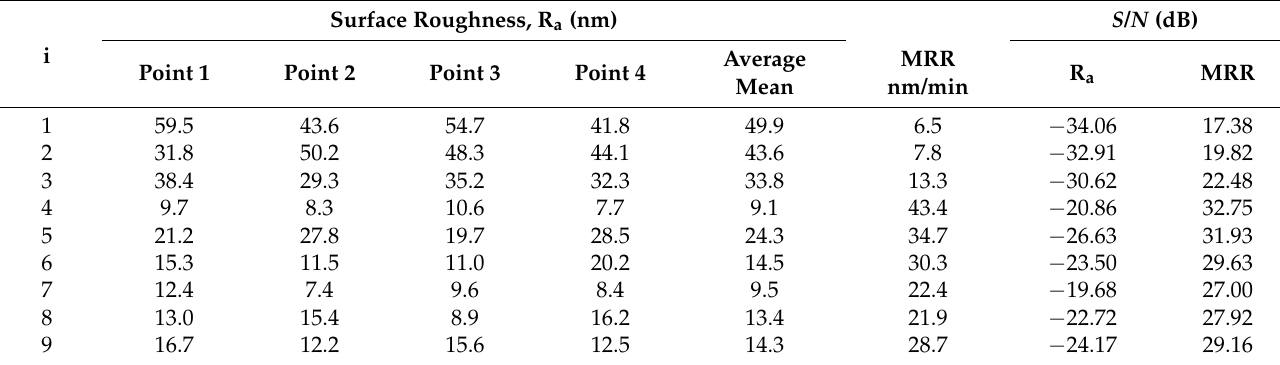
Table 4. Polishing test results and S / N